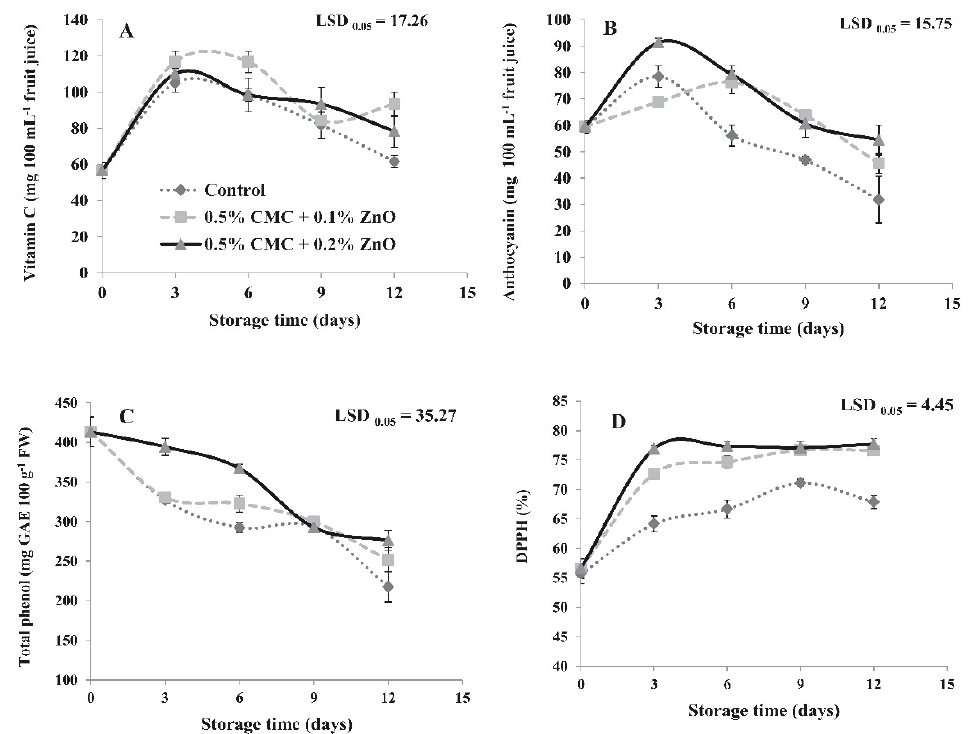
Figure 3. Storage time vs. total value of Vitamin C ( A ), anthocyanin ( B ), total phenol ( C ), and antioxidant capacity ( D ) in pomegranate arils either uncoated or coated with CMC-ZnO NPs. Reproduced with permission from [44]. Copyright 2017, Elsevier.